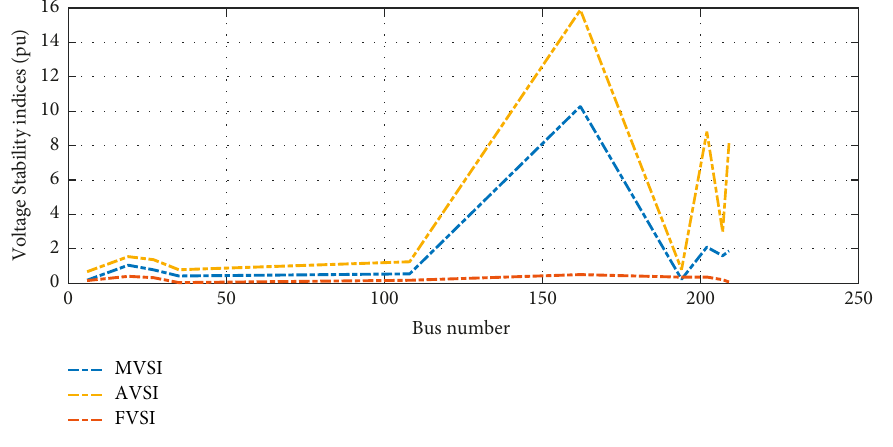
Figure 7: Voltage stability indices at 20% load